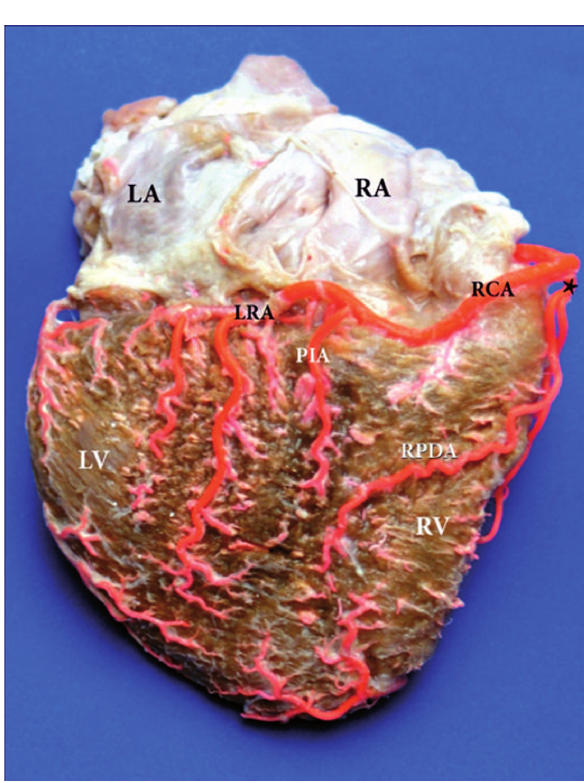
Fig. 4 - Posterior heart view. RDPA: Right posterior diagonal artery originated from right marginal artery (*). RV: right ventricle. LV: Left ventricule. RA: Right atrium LA: Left atrium PIA: Posterior interventricular artery. LRA: Left retroventricular artery. RCA: Right coronary artery